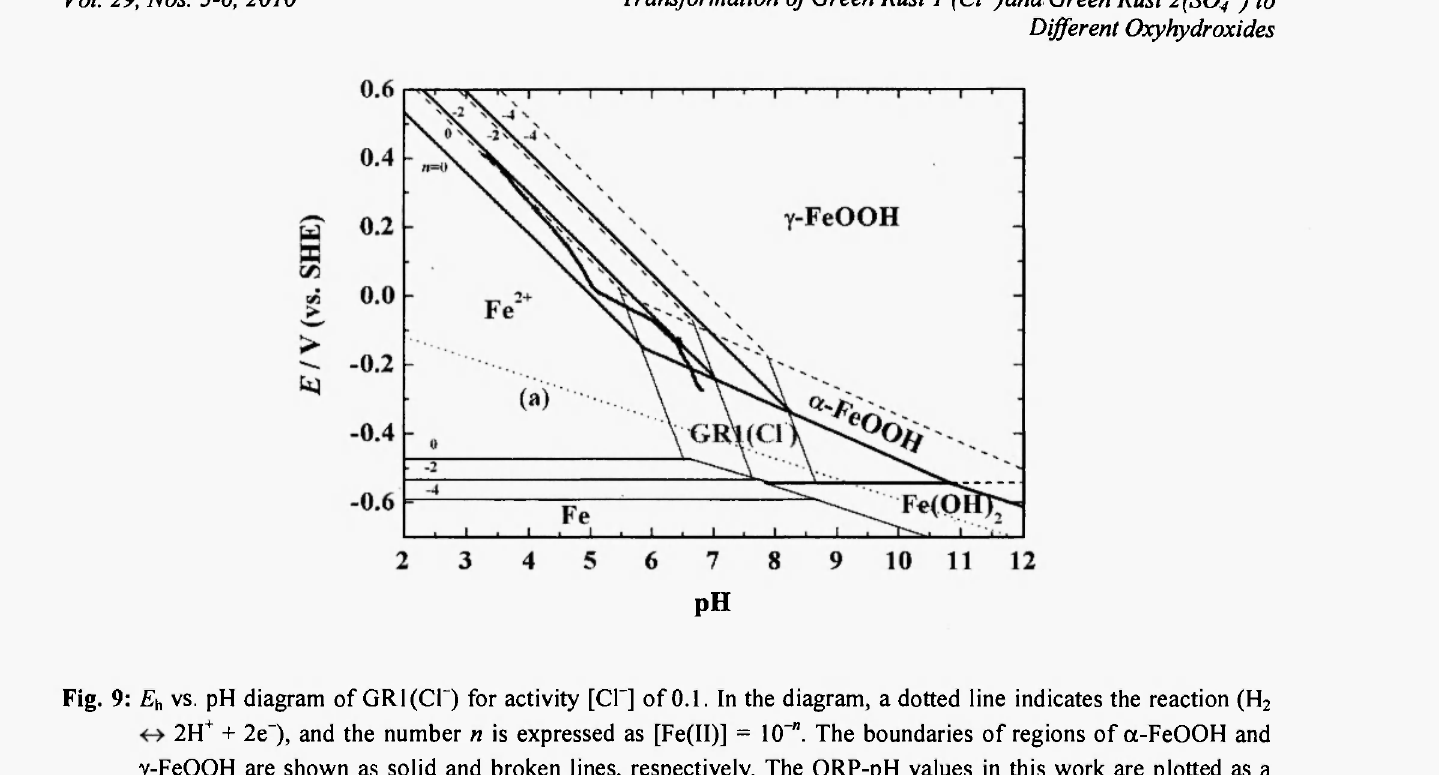
Fig. 9: £ h vs. pH diagram of G R l ( CO for activity [CI"] of 0.1. In the diagram, a dotted line indicates the reaction (H 2 2H + + 2e~), and the number η is expressed as [Fe(II)] = 10~". The boundaries of regions of α-FeOOH and γ-FeOOH are shown as solid and broken lines, respectively. The ORP-pH values in this work are plotted as a tracking line in this figure.